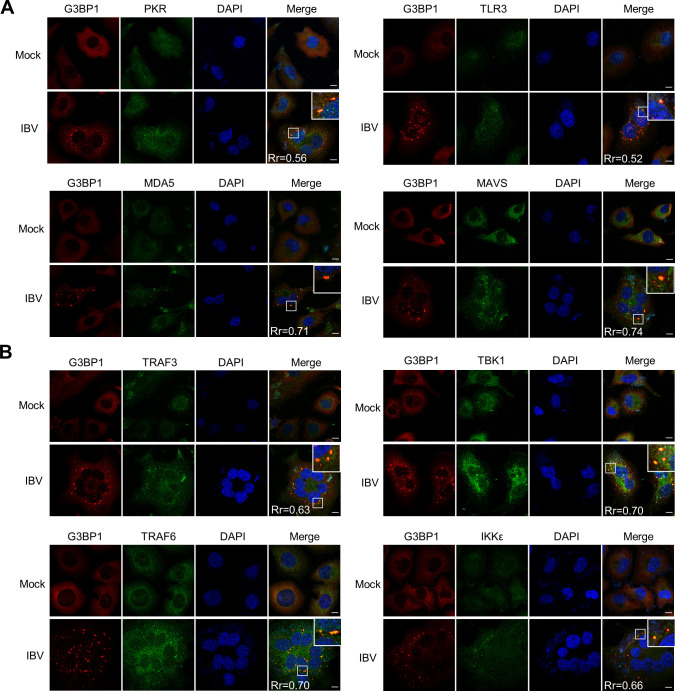
PRRs and innate immunity signaling intermediates aggregate to IBV-induced SGs.(A and B) H1299 cells were mock-infected or infected with IBV followed by immunostaining at 20 h.p.i.. Anti-G3BP1 (red) was used to monitor SGs formation, and PKR, MDA5, TLR3, MAVS, TRAF3, TRAF6, TBK1, IKKε (green) were detected with corresponding antibodies. Cell nuclei were stained with DAPI (blue). The Pearson’s correlation coefficient was measured by using Image J. Scale bars, 10 μm. Images are representative of three independent experiments.